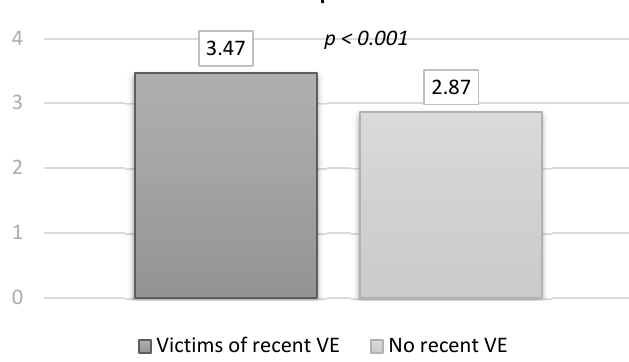
Figure 2. DEGS1 results: GP visits in the past 12 months stratified by recent VE. Victims who indicated to be strongly/very strongly impaired in well-being caused by recent psychological violence showed a significantly higher average number of GP contacts than victims who were less impaired (strong/very strongly impaired: mean GP visits: 4.24; SD ± 5.61; hardly/little impaired: 3.08; SD ± 5.18; not impaired: 2.67; SD ± 3.02, p = 0.001) (Figure 3). There was no significant difference in GP visits when stratifying by impairment due to physical violence (Figure 3). Concerning lifetime VE, no significant difference was found for having a GP nor for GP contact in the last 12 months.